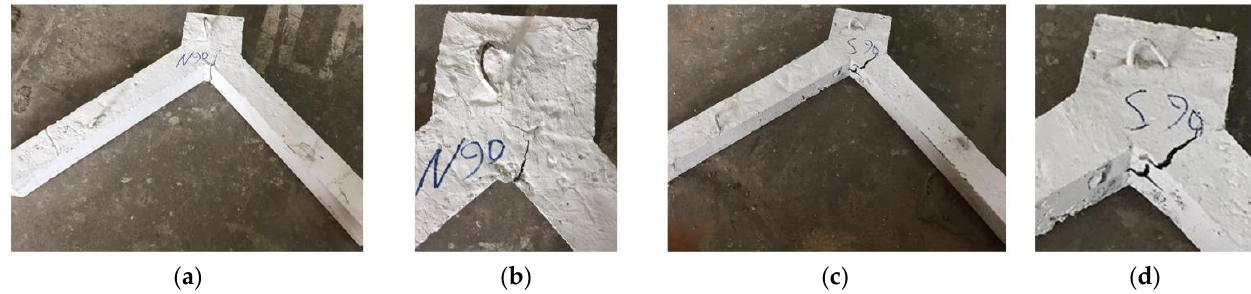
Figure 11. V-shaped columns with 90° angle ( a ) NRC-90, ( b ) NRC-90 failure zone, ( c ) FRC-90, and ( d ) FRC-90 failure zone.